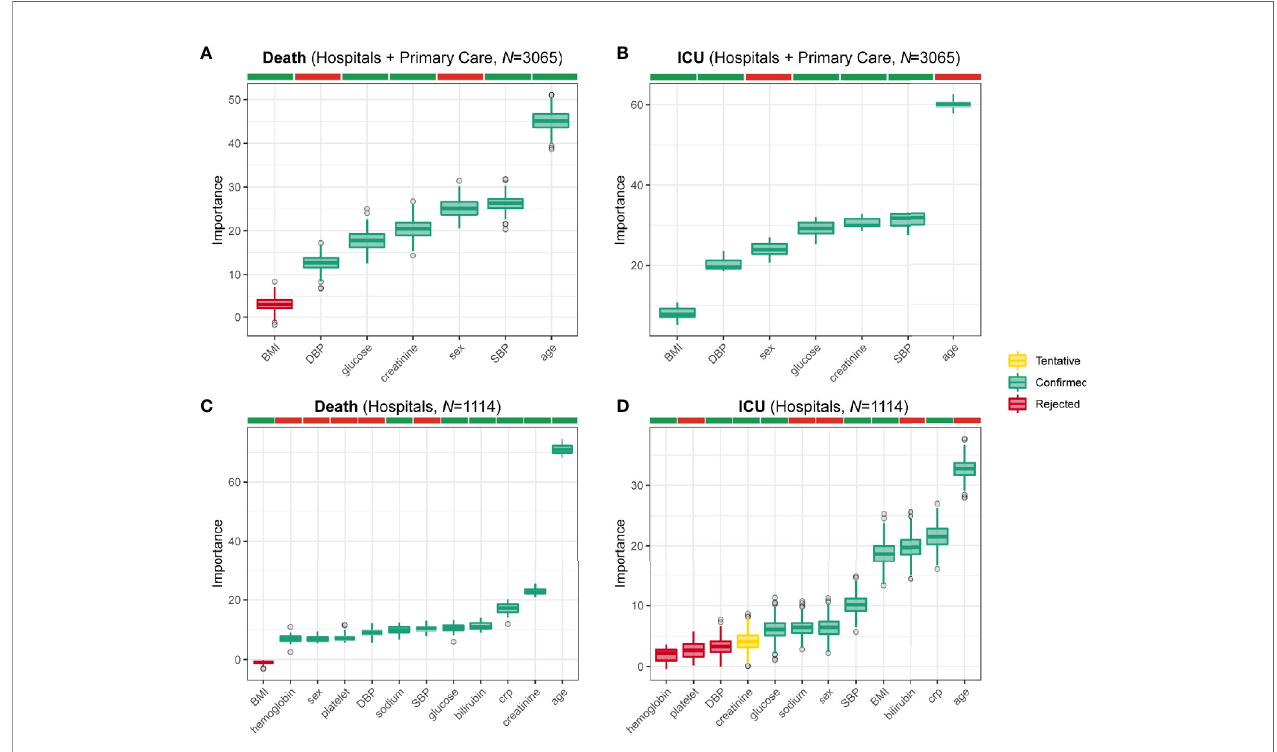
FIGURE 3 | Mortality and ICU admission prognostic variables identi fi ed from machine learning. Boxplots of the normalized permutation importance obtained from the Boruta algorithm for the potential prognostic variables associated to the (A) mortality from COVID-19 in all subjects ( n =3065), (B) admission to the ICU in all subjects ( n =3065), (C) mortality from COVID-19 in hospital patients ( n =1114), and (D) admission to the ICU in hospital patients ( n